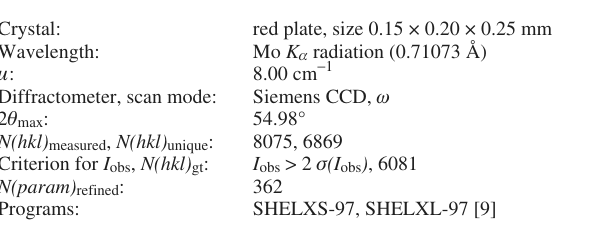
Table 1. Data collection and